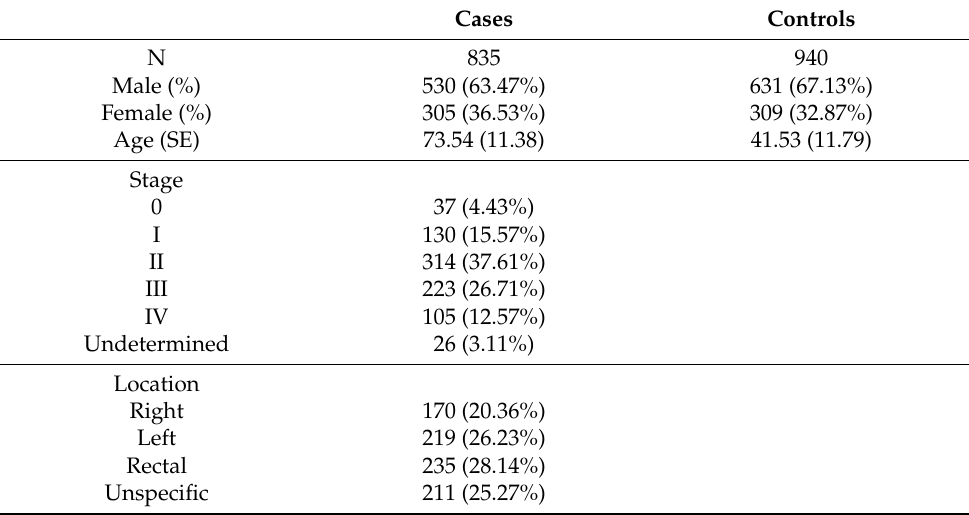
Table 1. Demographics of the participants.